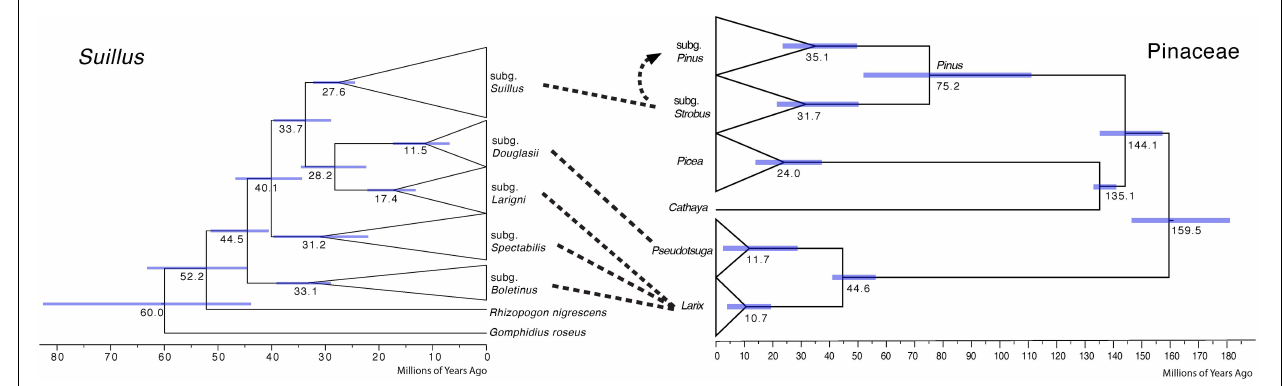
FIGURE 2 | Comparison of calibrated phylogenies of Suillus and host Pinaceae genera. The phylogeny of Suillus is on the left, where terminal taxa are collapsed into triangles and only subgenera are shown. The phylogeny of Pinaceae is on the right, where host genera and two subgenera of Pinus are annotated. The phylogeny of Pinaceae is referred from Leslie et al. (2012). Dashed lines between the two phylogenies indicate host associations. Subgenus Suillus first established symbiosis with subgenus Strobus and then switched to subgenus Pinus as shown by a dashed